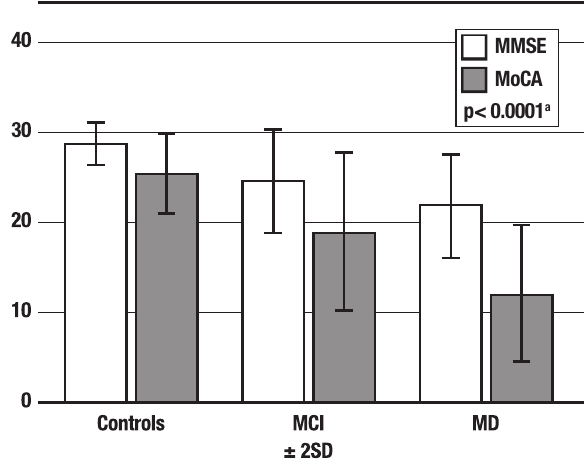
Figure 1. Performance in MMSE and MoCA-A by subgroups.